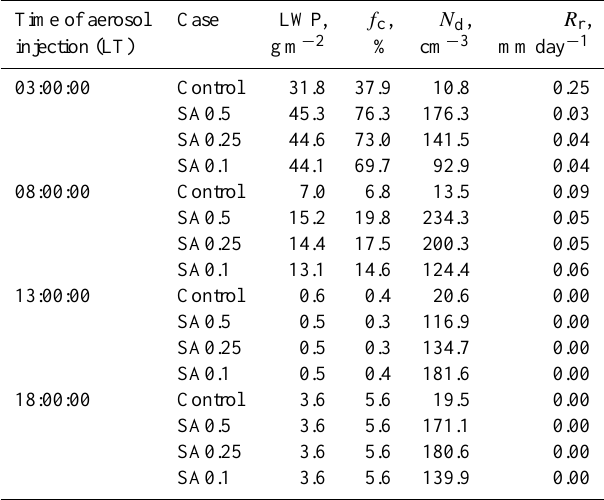
Table 3. Results for the weakly precipitating (WP) case. Notes as Table 2. Time of aerosol